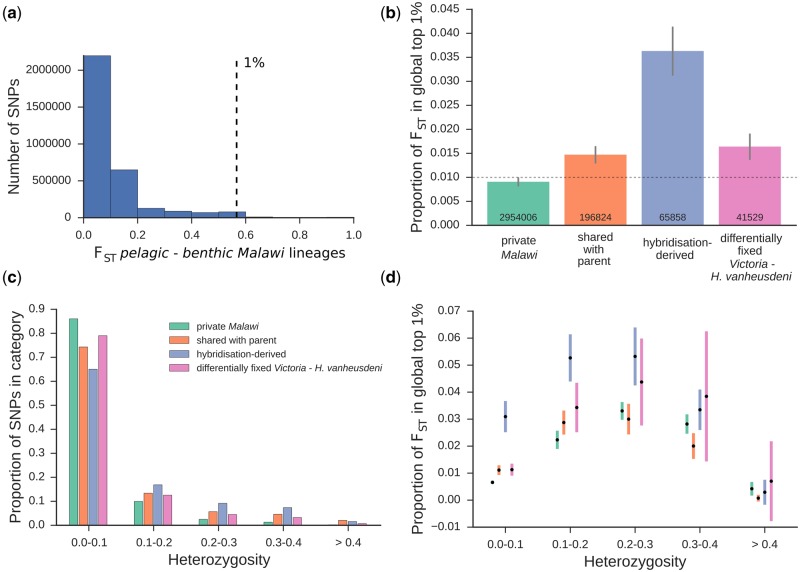
Distribution of FST outliers across variant categories described in table 1. (a) Histogram of FST values for all SNPs; FST was calculated treating the pelagic species (genera Rhamphochromis and Diplotaxodon) and benthic species (all other Malawi species) as two populations, corresponding to the first split in the radiation (Malinsky et al. 2018). The dashed line shows the top 1% FST value cutoff. (b) For each of the variant categories described in table 1, the proportion of variants that are in the global top 1% FST outliers (right of dashed line in panel a) is shown. The third category is expected to be enriched for hybridization-derived variants. The numbers inside the bars correspond to the number of SNPs in each category. Gray bars correspond to ±3 block-jackknifing standard deviations. The average of the first three bars, weighted by the number of variants in the categories, is 1% by construction (dashed gray line). (c) For each variant category, the proportion of SNPs in different heterozygosity bins is shown. Heterozygosity is averaged across Malawi samples. (d) Proportion of FST outliers in the variant categories described in table 1 stratified by heterozygosity. Error bars correspond to ±3 block-jackknifing standard deviations.